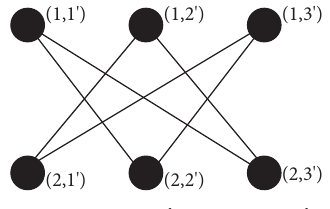
Figure 1: NEPS P